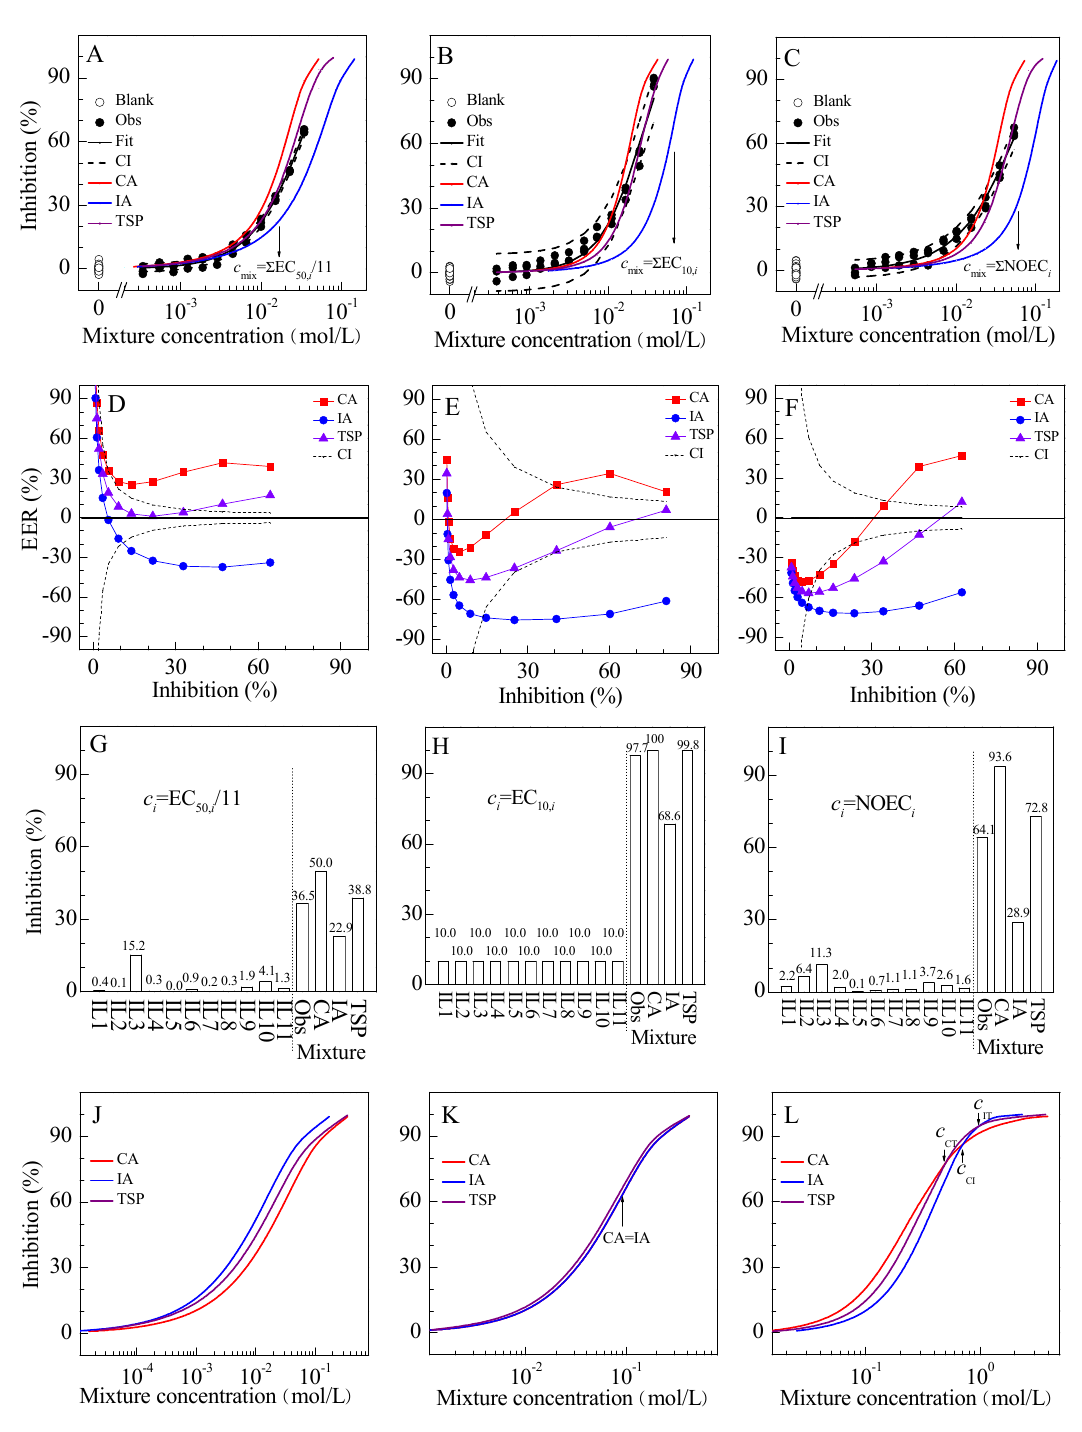
Figure 2. ( A – C ) Concentration–response curves (CRCs) for the inhibitory effects of ionic liquid (IL) mixtures of M1 ( A ), M2 ( B ), and M3 ( C ) on luciferase luminescence. ( D – F ) Comparison of effect residual ratio (ERR) of CA, IA, and TSP models at different effect levels for mixtures of M1 ( D ), M2 ( E ), and M3 ( F ). ( G – I ) Comparison of the effects on luciferase luminescence of mixtures with those of individual ILs which concentration correspond to EC /11 ( G ), EC ( H ), and NOEC ( I ) respectively. ( J – L ) Comparison of the 50 10 CRCs predicted by CA, IA, and TSP for three virtual mixtures of V1 ( J ), V2 ( K ), and V3 ( L